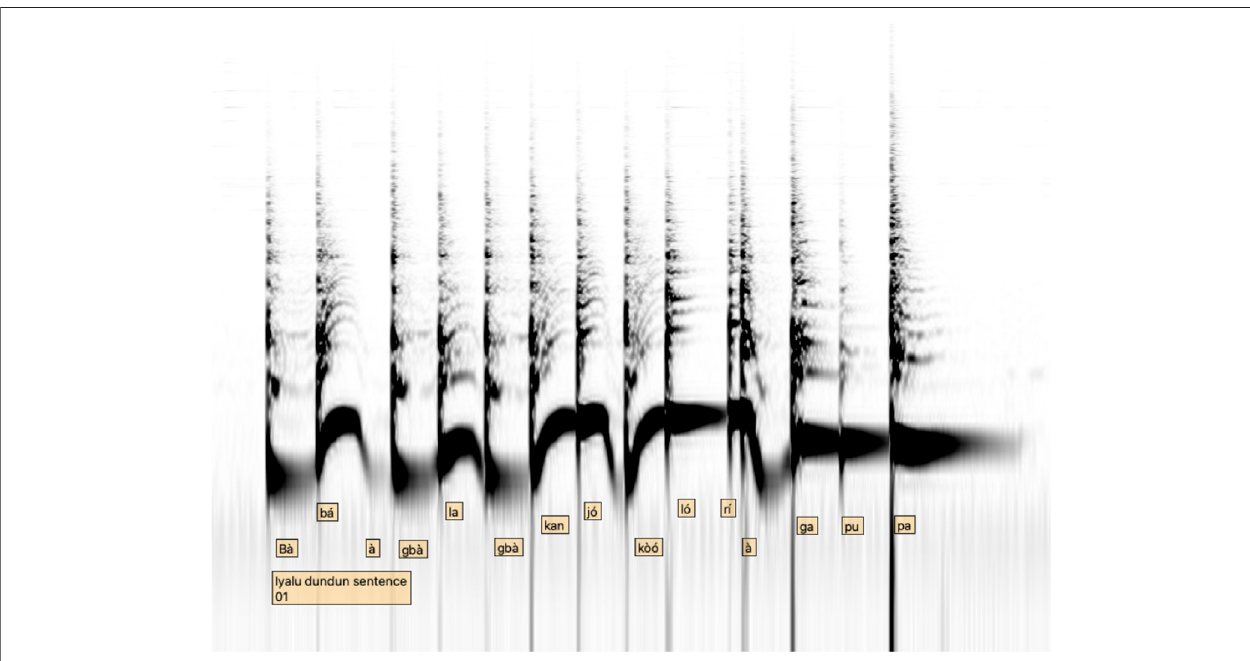
FIGURE1 | Ìyáàlùdùndún spectrogram for thesentence “ Bàbá àgbàlagbà kaán jókòólórí àga pupa ” ( “ there isan old man sitting on ared chair ” ).All spectrograms in the present study were generated with the freeware Sonic Visualizer, available under https://www.sonicvisualiser.org/ (downloaded on January 08, 2021).